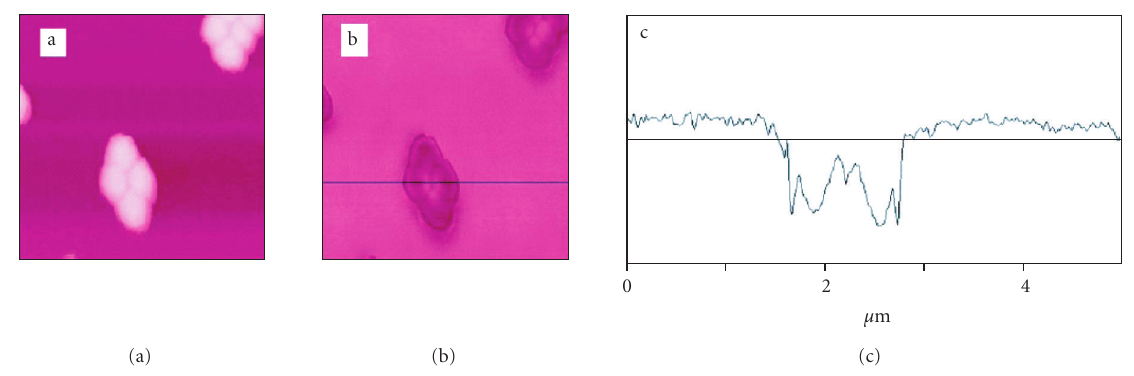
Figure 15: Shear-force AFM (a) and apertureless SNOM (b) of small aggregates of 430nm styrene-acrylamide copolymer latices on mica and cross section (c) through the optical contrast showing both highly resolved-stripes contrast at the edges and materials contrast.